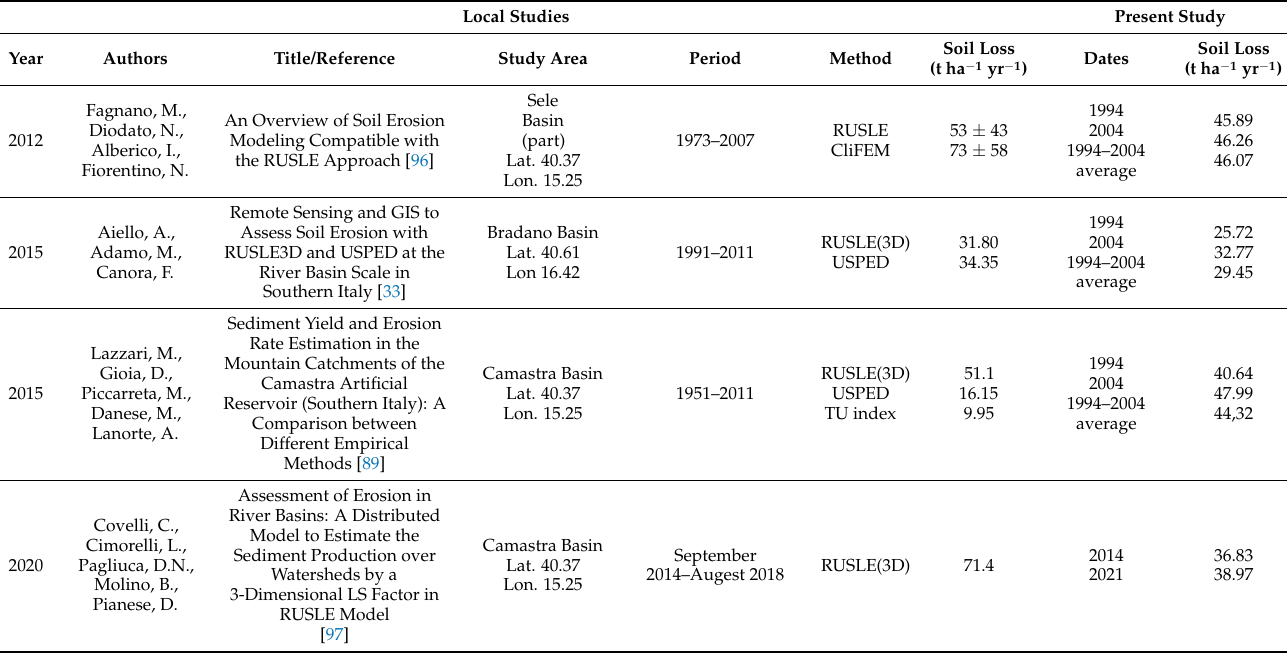
Table 5. List of the studies at local level used for the comparison of the RUSLE estimations imple- mented in the present